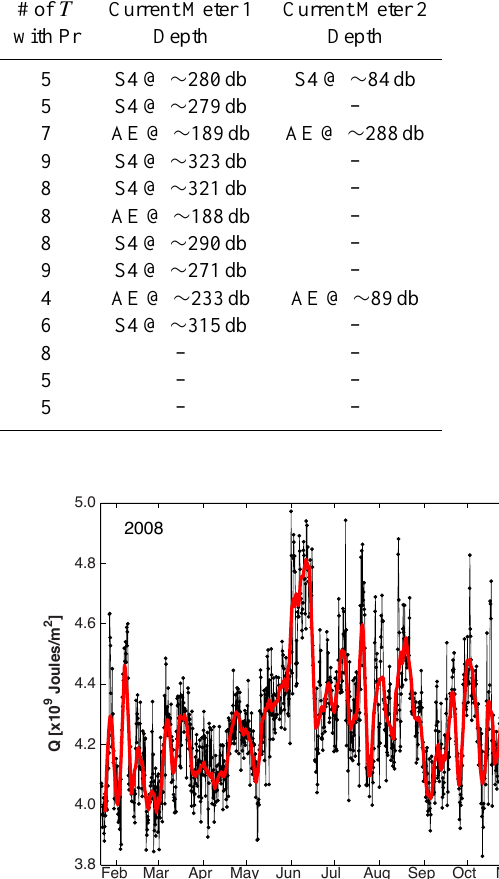
Table 1. Mooring locations, years at location and sensor suite. Mooring numbers agree with numbered circles in sample grid of Fig. 1. Current meter abbreviations are S4: InterOcean, and AE: JFE ALEC Electronics – both are electromagnetic current meters. Mooring Location/